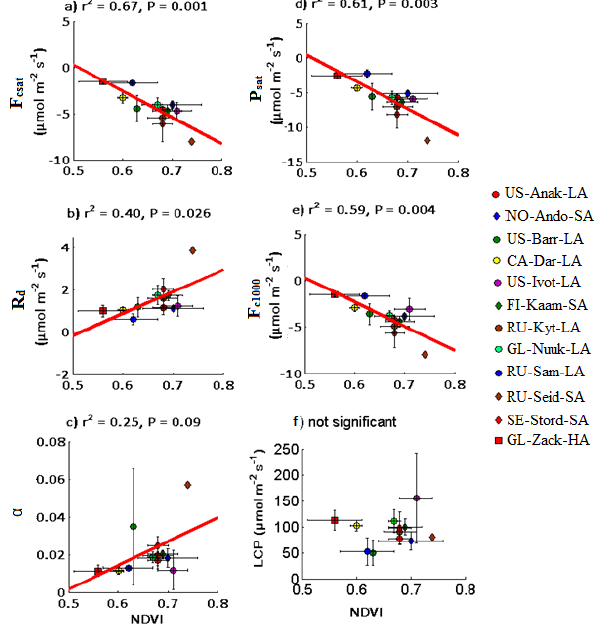
Figure 3. Relationships between peak season NDVI and (a) light saturation NEE, F csat ; (b) dark respiration, R d ; (c) rate of car- bon assimilation with initial increase in light, α ; (d) potential photosynthesis at light saturation, P sat ; (e) NEE when PPFD is 1000µmolm − 2 s − 1 , F c 1000 and (f) light compensation point (LCP). Red line represents linear fit between peak season NDVI and LRC parameters while error bars are standard deviations.